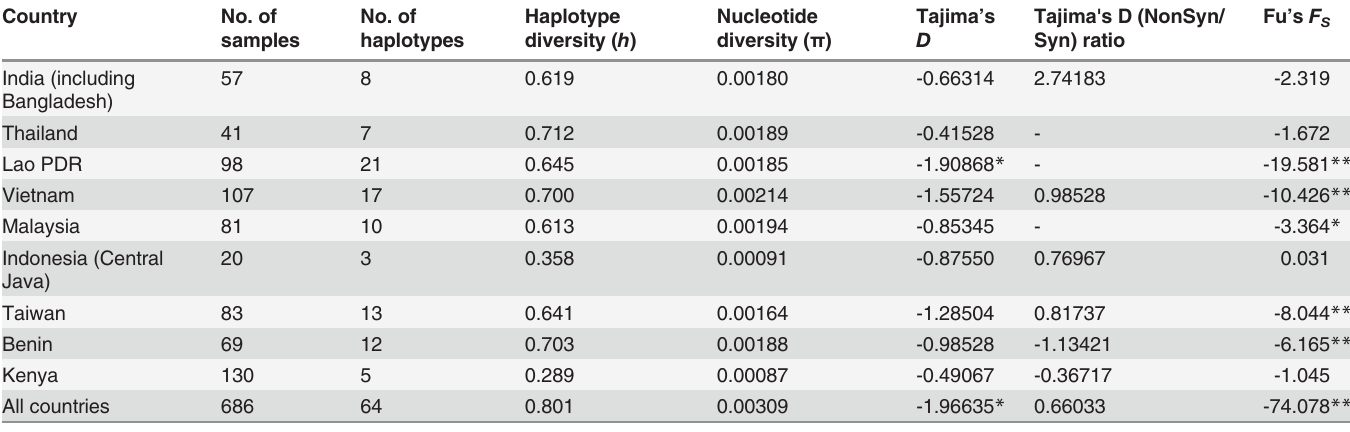
Table 2. List of number of samples studied, number of haplotypes, haplotype diversity ( h ), nucleotide diversity ( π ), Tajima ’ s D and Fu ’ s F S tests for Maruca vitrata populations from ten countries in South and Southeast Asia, and sub-Saharan Africa. Country